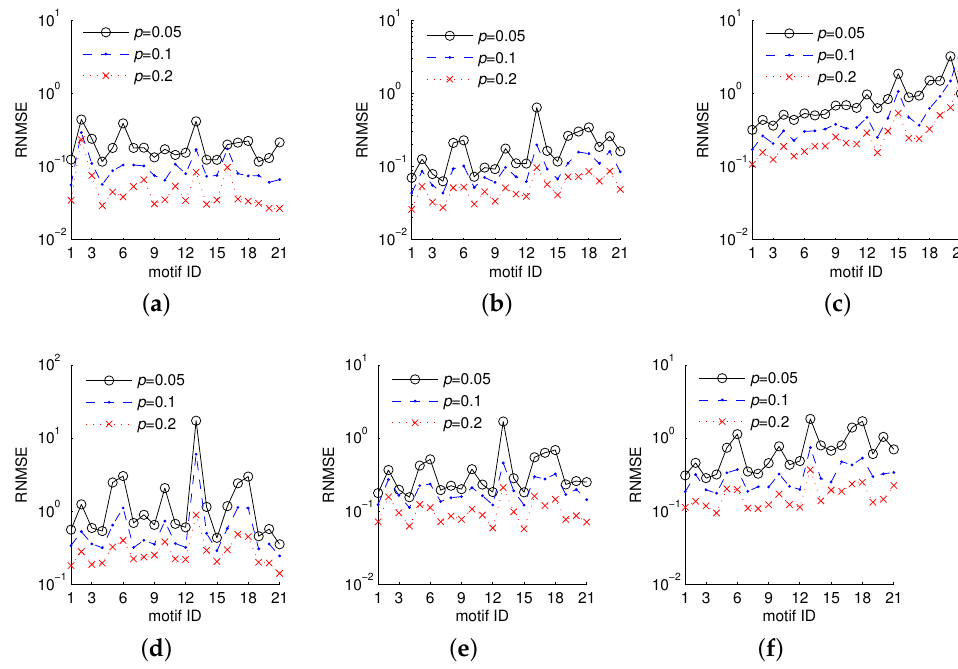
( 5 ) Figure 10. NRMSEs of ˆ n , the motif frequency estimates of five-node undirected motifs for p = 0.1, i p = 0.2, and p = 0.3, respectively. Com-Amazon, com-DBLP, p2p-Gnutella08, ca-GrQc, ca-CondMat, and ca-HepTh have 8.50 × 10 9 , 3.34 × 10 10 , 3.92 × 10 8 , 3.64 × 10 7 , 3.32 × 10 9 , and 8.73 × 10 7